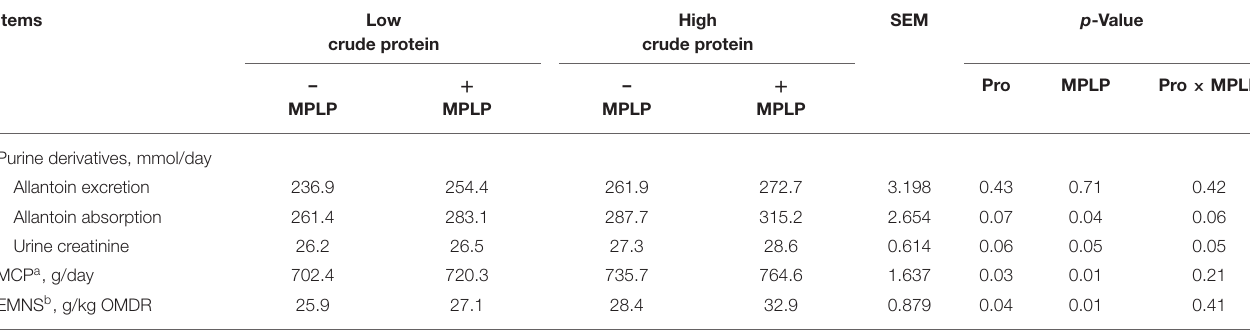
TABLE 5 | Effect of crude protein level and mangosteen peel liquid-protected soybean meal on microbial protein synthesis in lactating dairy cows. Items Low High crude protein crude